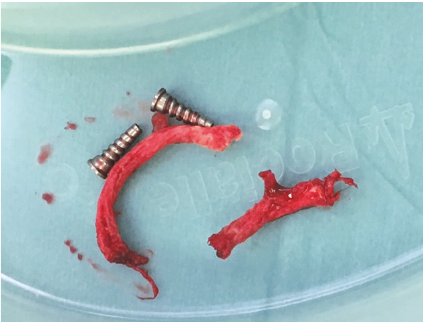
Figure 5: Intraoperative photograph demonstrating substantial fraying to LARS three weeks after insertion. The left fragment is the lateral limb of the LARS and the right fragment is the medial